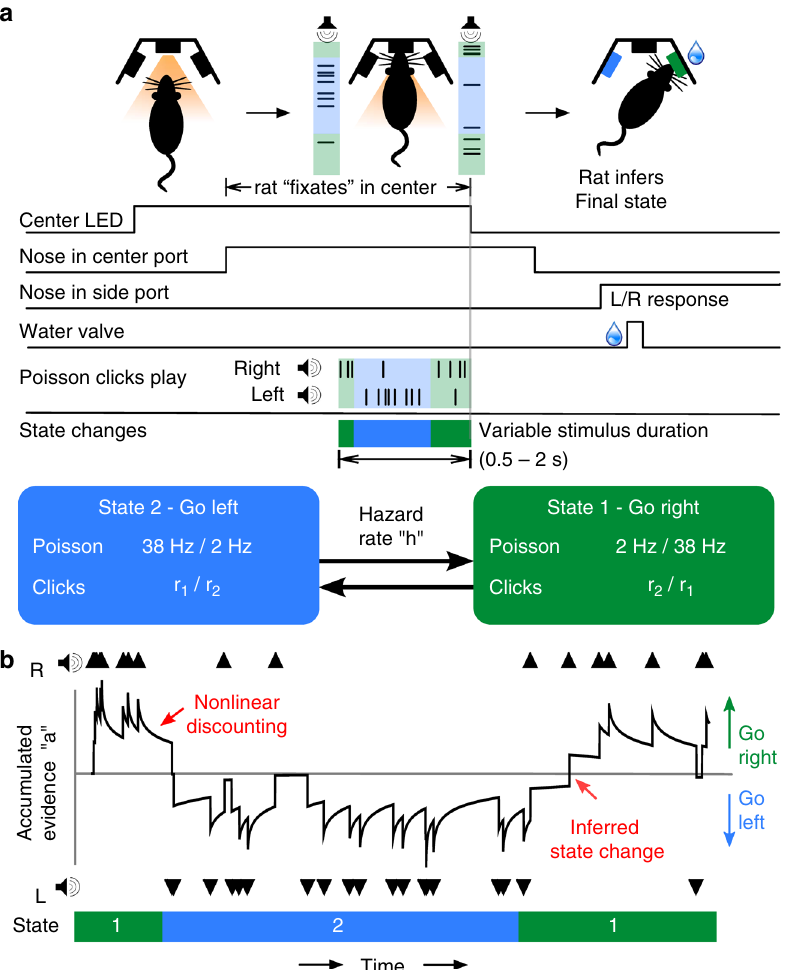
Fig. 1 Dynamic Clicks Task structure and example trial. a Schematic of task events and timing. A center light illuminates indicating the rat may initiate a trial by poking its nose into a center port. Auditory clicks are generated from state-dependent Poisson processes (the two states are schematized by light green and light blue backgrounds) and played concurrently from left and right speakers. The hidden state toggles between two states according to a telegraph process with hazard rate h . When the auditory clicks end, and the center light turns off, the rats must infer which of the two states the trial ended in and report their decision by poking into one of two reward ports. Trials have random durations so the rat must be prepared to answer at all time points. b An example trial. The hidden state transitions randomly, and the auditory clicks (black triangles) are generated accordingly. The optimal inference process (black line; see text for its derivation) accumulates clicks, and discounts accumulated evidence proportionally to the volatility of the environment and click statistics. For the optimal process, a choice is generated at the end of the trial according to whether the optimal inference variable is above or